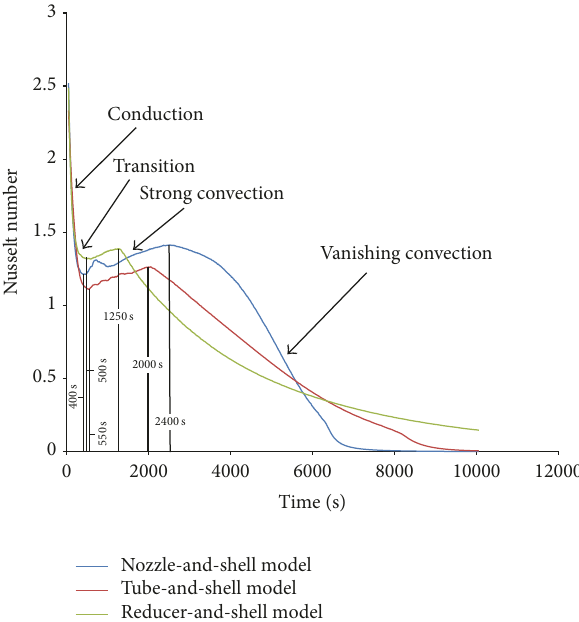
Figure 10: The average of surface Nusselt